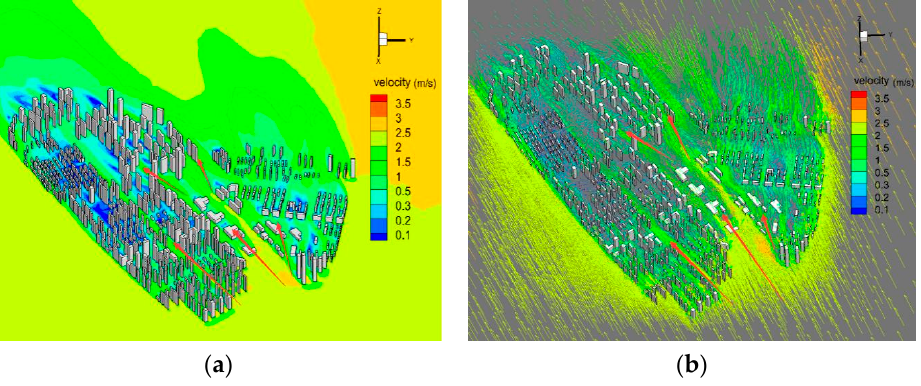
Figure 7. Urban wind velocity distribution in winter: ( a ) Contour plot; ( b ) Vector plot.